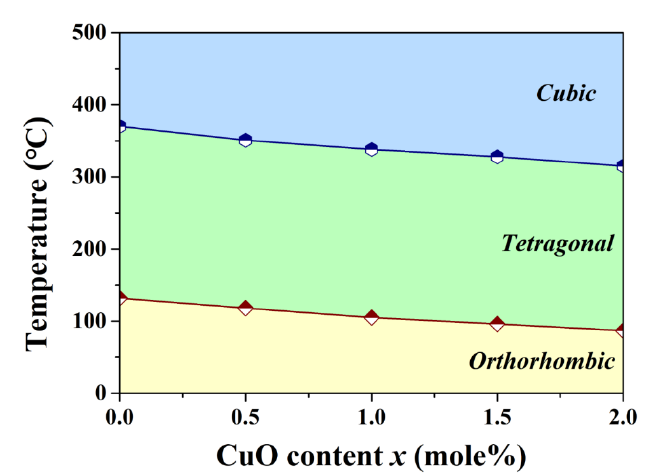
Figure 3. Temperature dependence of the dielectric constants for NKLNTS-ST- x CuO ( x = 0~2.0 mol%) ceramics measured at 100 kHz.